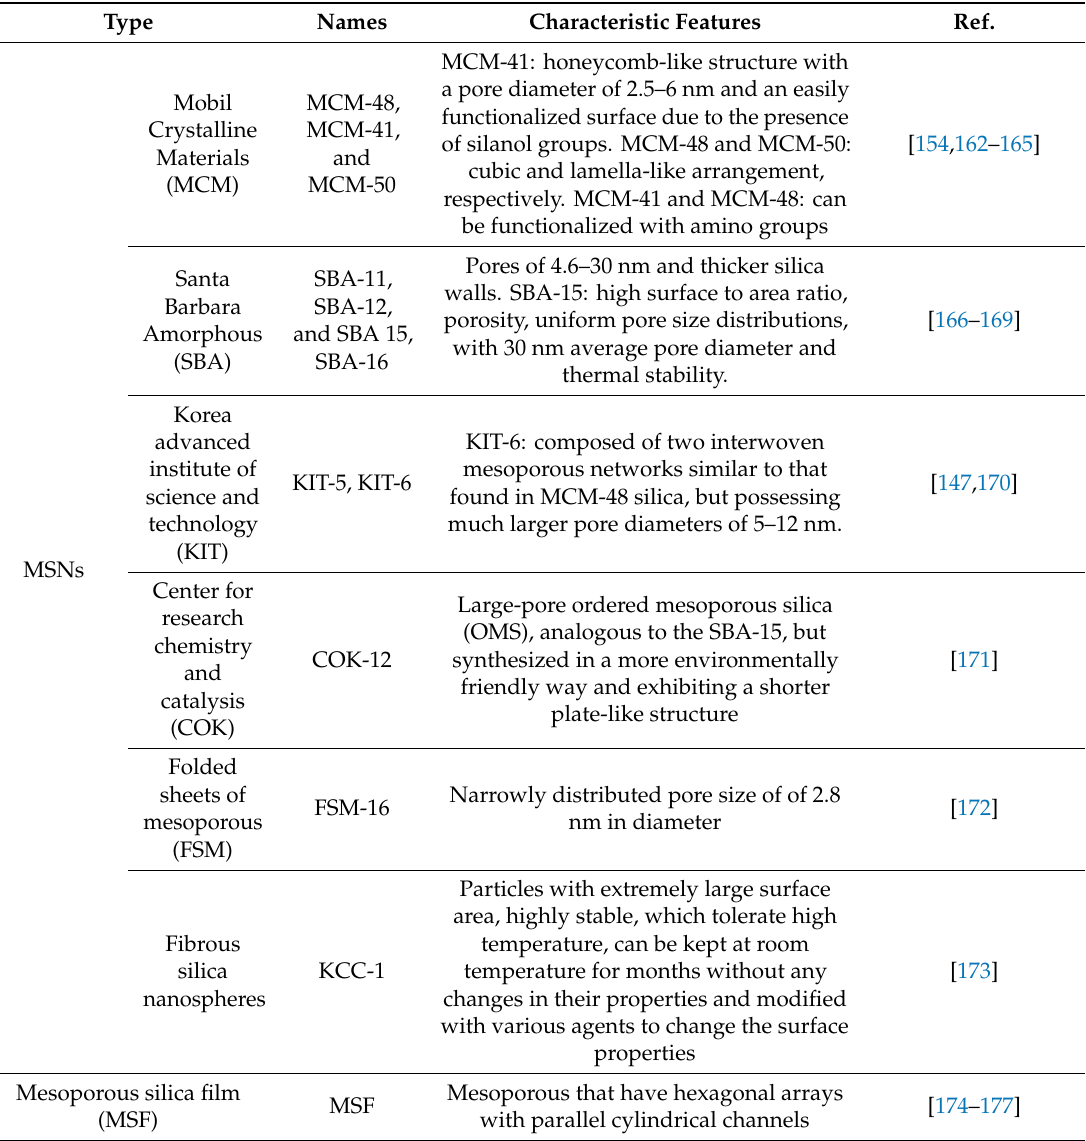
Table 3. Reported mesoporous nanomaterials: types, names, and characteristic features [153]. Names Characteristic Features Ref.